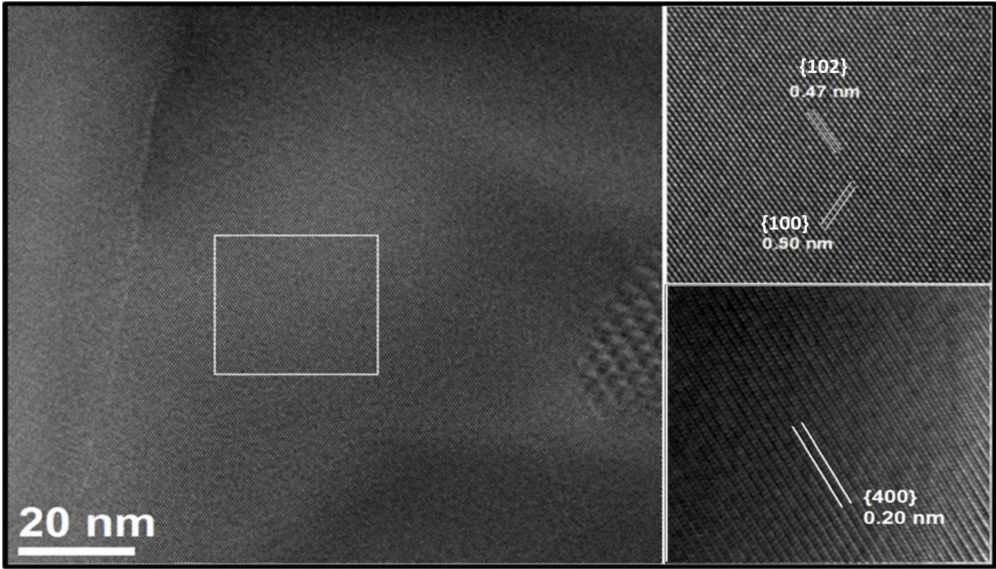
Figure 3. HRTEM images of S r0.3 Ba 0.4 Pb 0.3 Fe 12 O 19 /(CuFe 2 O 4 ) x composite